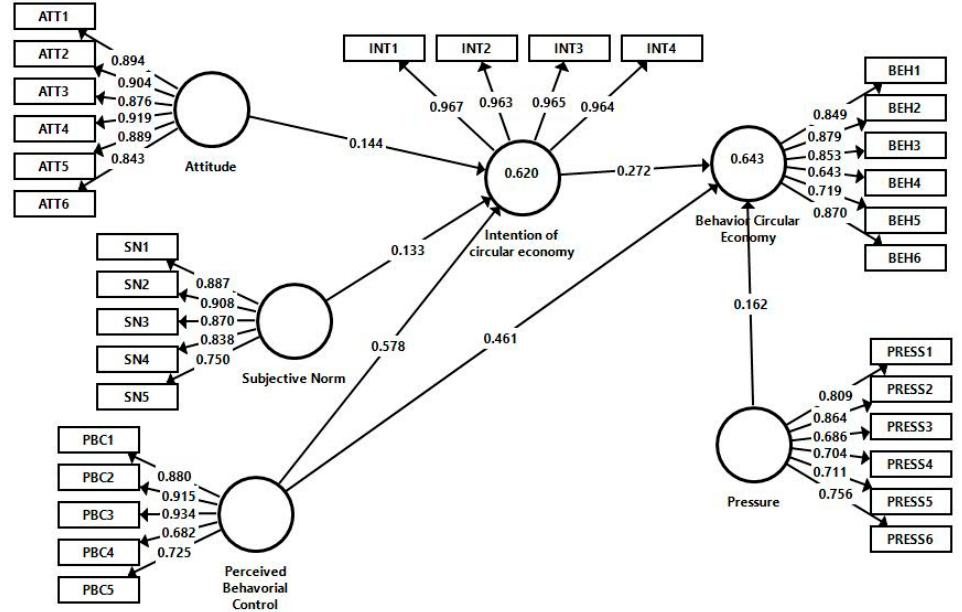
Figure 2. Research model tested.